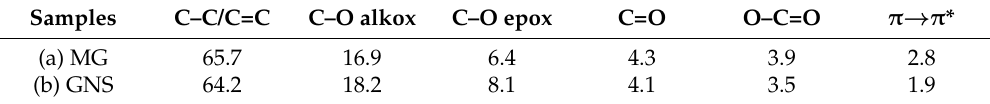
Figure 4. ( a ) XPS survey for MG and GNS and XPS spectra for the C 1s photoemission peak of ( b ) MG and ( c ) GNS. Table 3. Contribution of the six components used in fitting of the C 1s photoemission peak (in %). Samples